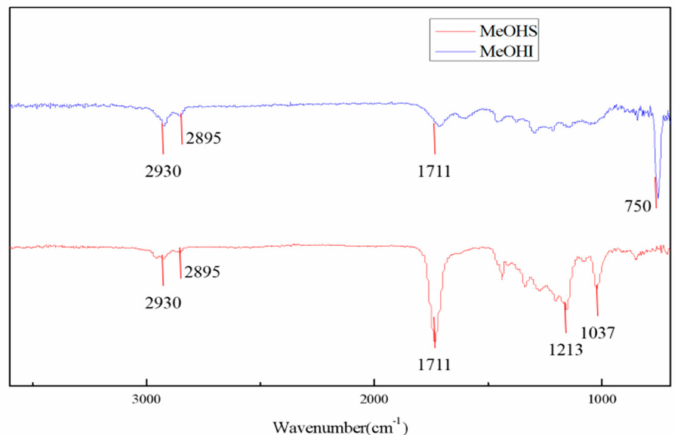
Figure 3. The infrared spectra of MeOHS and MeOHI after catalytic oxidation reaction: the red line represents MeOHS and the blue line indicates MeOHI after the catalytic oxidation